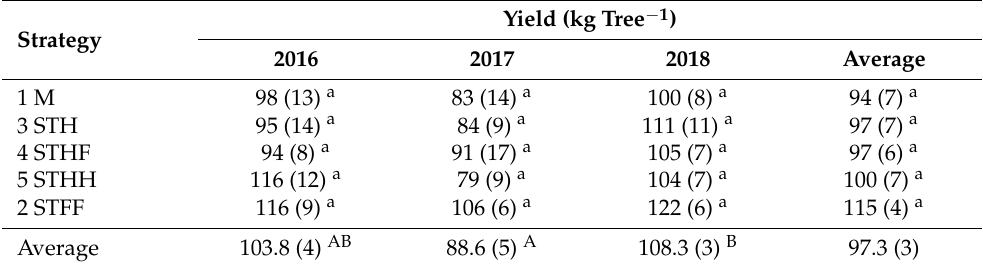
Table 7. Yield (kg tree − 1 ) for each strategy and year, ordered by the increasing 3-year average yield 1 . Strategy